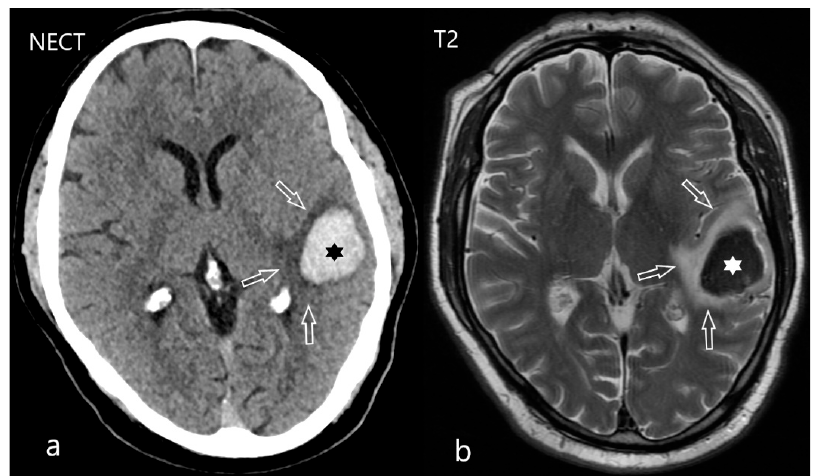
Figure 1. Acute intracerebral hematoma. 57-year-old male was referred with one day aphasia with acute onset. There is an acute intracerebral hematoma (star) on NECT ( a ) and on T2- weighted MRI ( b ) situated in the left temporal lobe. Perifocal vasogenic edema is also present (arrows). The source of hemorrhage was a pial arteriovenous malformation.